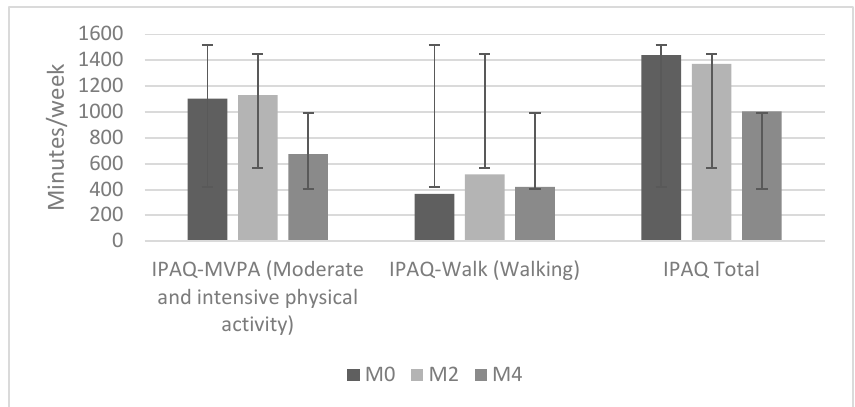
Figure 3. Self-assessment of weekly PA (in minutes) at the start of the intervention (M0), after two months of participation (M2), and at the end of the intervention (M4) (n = 13).